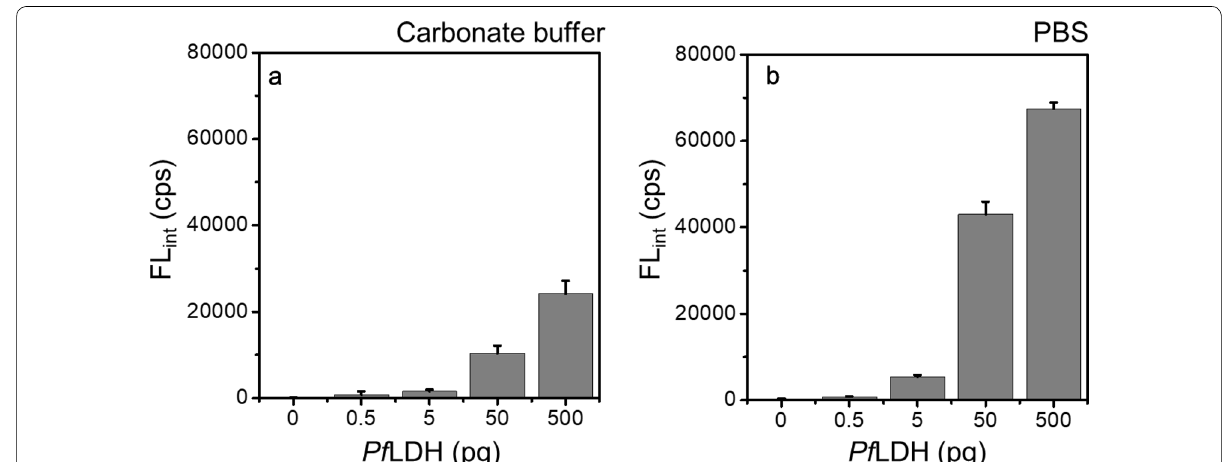
Fig. 3 Optimization of the Cap-Ab adsorption. The Cap-Ab coating efficiency was compared two coating buffers. To detect the Pf LDH in the microfluidic microplate, the Cap-Ab was prepared in a carbonate-bicarbonate buffer (pH 9.6) and b PBS (pH 7.4). The chemiluminescence were measured by BioTek multimode reader (Excitation: 530 nm, Emission: 590 nm, n =